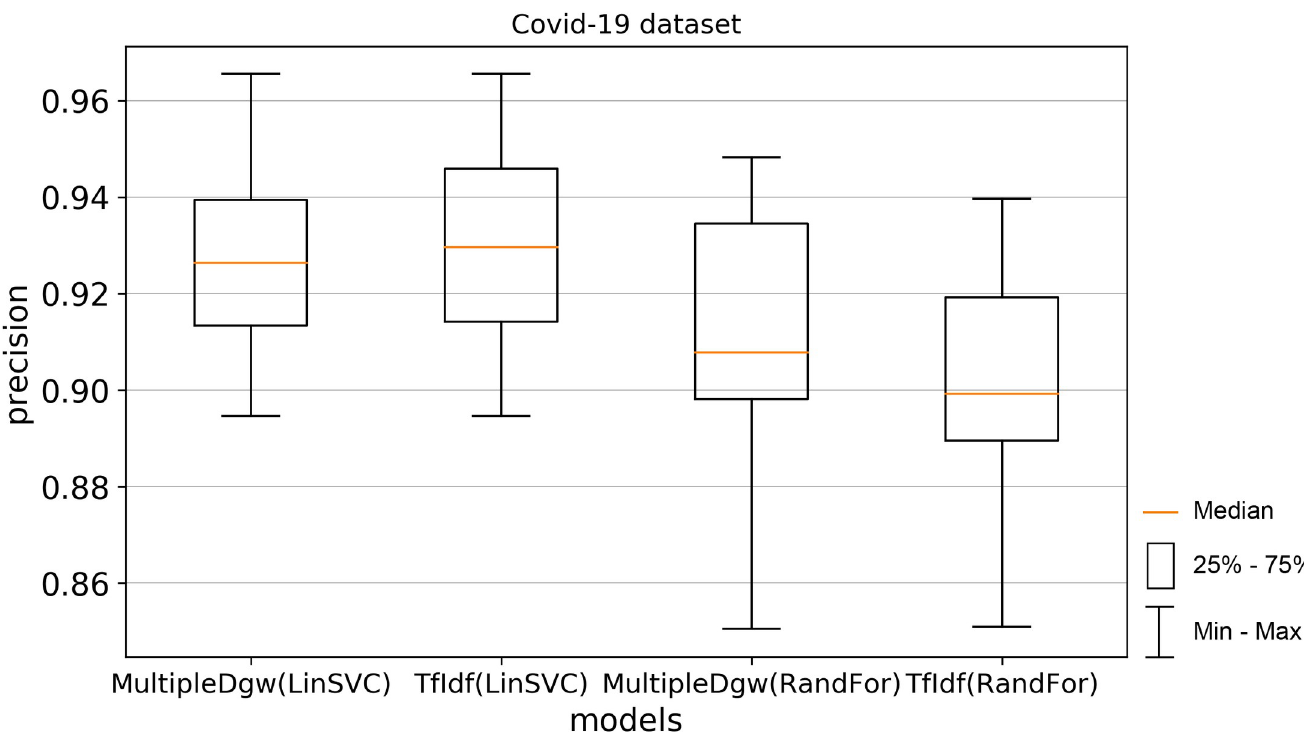
Fig 4. Boxplot for the model performance measurements—precision for dataset Covid-19.